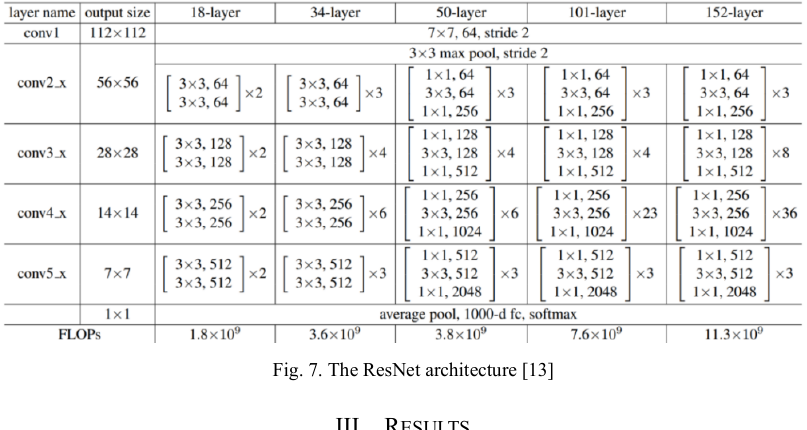
Fig. 7. The ResNet architecture [13]